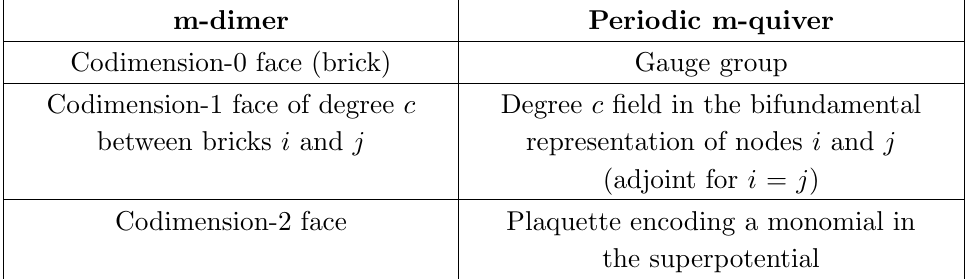
Table 1. Dictionary mapping m -dimers to periodic m -quivers (equivalently, toric m -quivers with